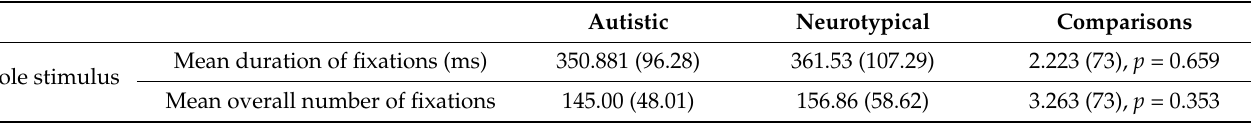
Table 3. Details of eye movement data for the two groups including the duration and number of fixations, and dwell time to whole figure and head-only stimuli (compared using independent samples t- tests). Scores show the mean and deviation in brackets.